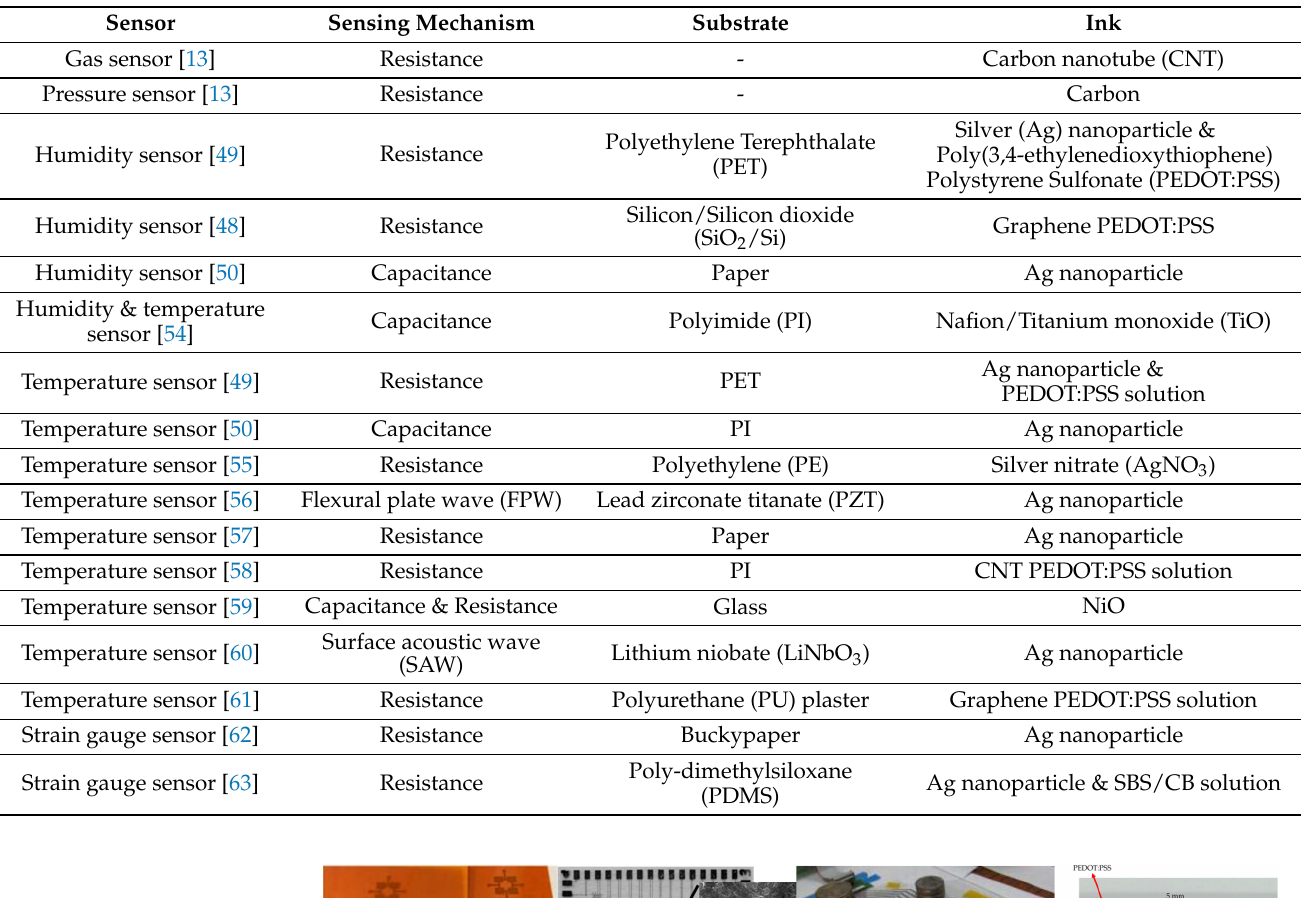
Table 1. Collection of substrate and ink types used in various printed sensors.